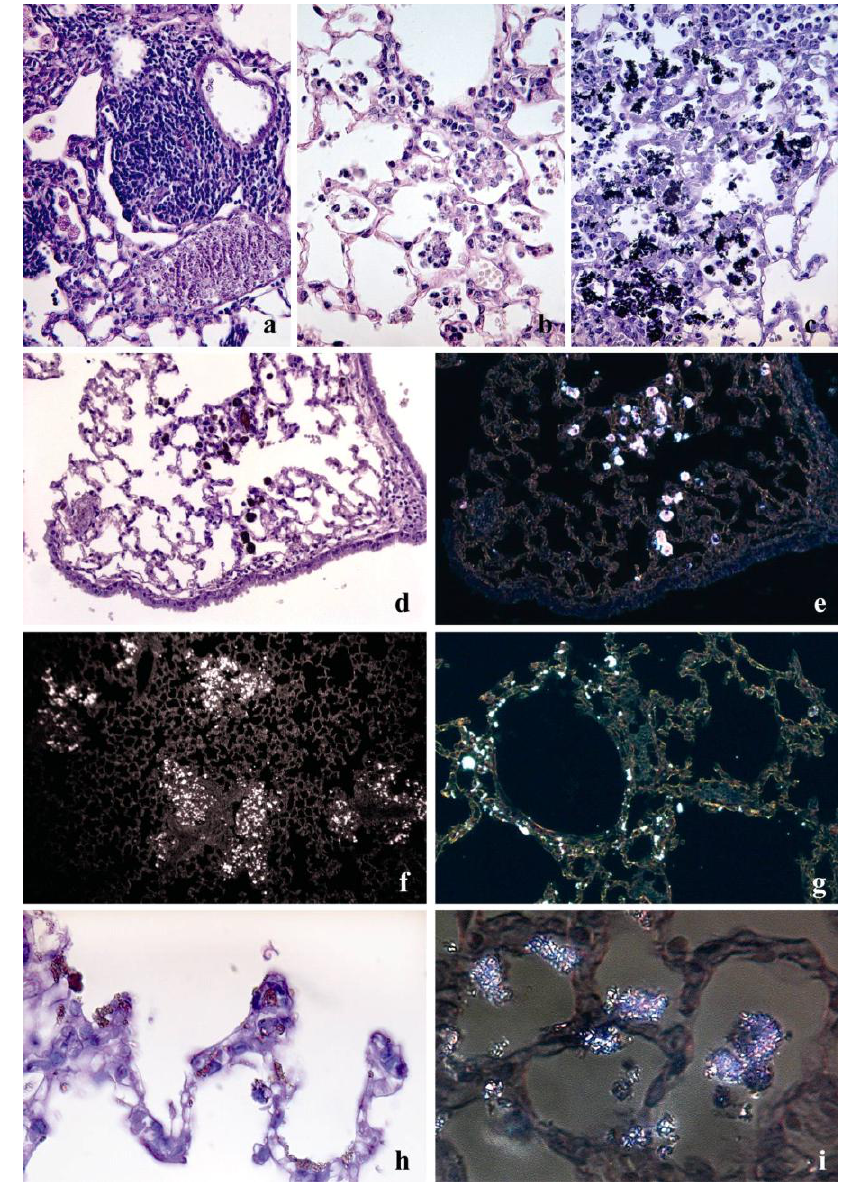
FIGURE 3. Representative histological sections of lungs from mice that had received a single i.t. instillation of quartz (SRM1878a or DQ12) or an instillation of a species of TiO . The animals showed different inflammatory 2 changes as well as deposition of particles. (a) Three months postinstillation, subchronic infiltration of inflammatory cells close to two vascular structures in a DQ12-treated mouse. (b) Focal acute inflammation in the alveoli 24 h after i.t. instillation of SRM1878a. (c) Plenty of macrophages in the alveoli containing black particles in a mouse treated 24 h previously with TiO MR. (d and e) Three months post-treatment of a mouse with TiO NAM; the section was 2 2 photographed using bright- and dark-field microscopy, respectively. The macrophages are easily identified. (f) A somewhat uneven distribution of micro-size rutile particles 24 h postinstillation, demonstrated at low magnification and dark-field microscopy. (g) Particles of TiO NAM 24 h postinstillation were mainly in the interstitial tissue and 2 not in macrophages. (h) TiO NAM 24 h postinstillation are accumulated in macrophages, but are also seen directly 2 on the surface of the alveoli. (i) Larger magnification of the same exposure as in (h) using polarization microscopy. Macrophages containing particles are seen in the lumen of the alveoli. The resolution is superior compared to the dark-field micrographs. Staining hematoxylin/PAS, magnifications: a, b, and c: ×150; d and e: ×60; f: ×25; g: ×250; h: ×480; and i: